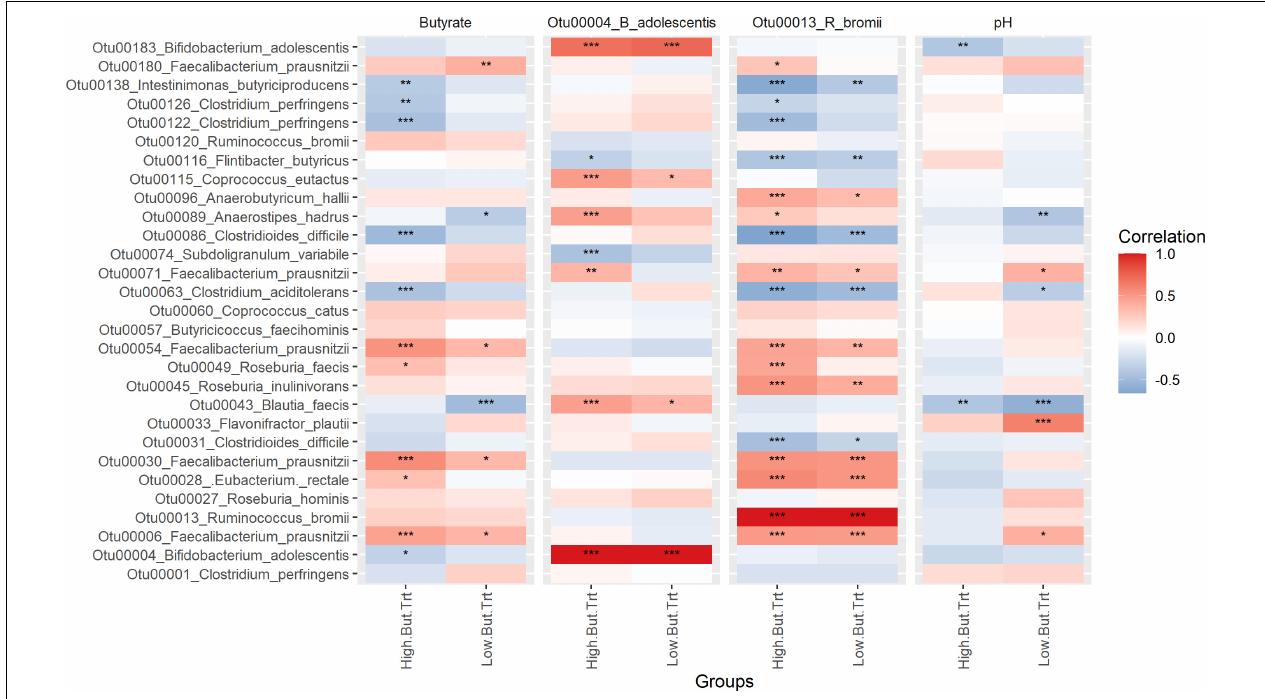
FIGURE 7 | Spearman correlations between fermentation features, resistant starch degrading organisms and butyrate-producing organisms. Centered-log-ratio transformed counts of bacterial taxa were tested for Spearman correlation with similarly transformed counts of resistant starch degrading taxa, butyrate concentrations and pH. The heatmap is colored by correlation coefficient. Significance levels are the FDR-adjusted p -values across each panel. * P < 0.05, ** P < 0.01, *** P < 0.001. Panels for each comparison are divided into the low butyrate producing treatments (water control, amylopectin, corn starch, extracted retrograded potato starch, retrograded whole potato and tiger nut flour) and the high butyrate producing treatments (banana flour, high amylose maize starch, chemically cross-linked high amylose maize starch, potato starch, potato starch with fecal samples supplemented with Bifidobacterium adolescents , potato starch with fecal samples supplemented with Ruminococcus bromii and chemically cross-linked tapioca starch). The low butyrate treatments are those producing equal to or less butyrate than in the water control, whereas the high butyrate treatments are those that produce more butyrate than in the control